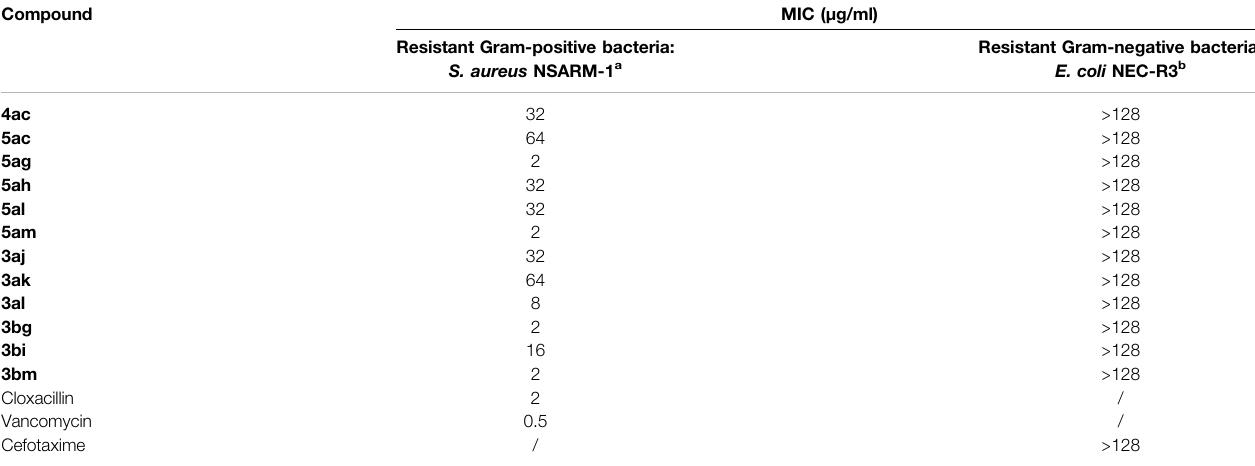
TABLE 4 | MIC values ( μ g/ml) of the synthesized compounds (3, 4, and 5) against clinical resistant bacterial strains.